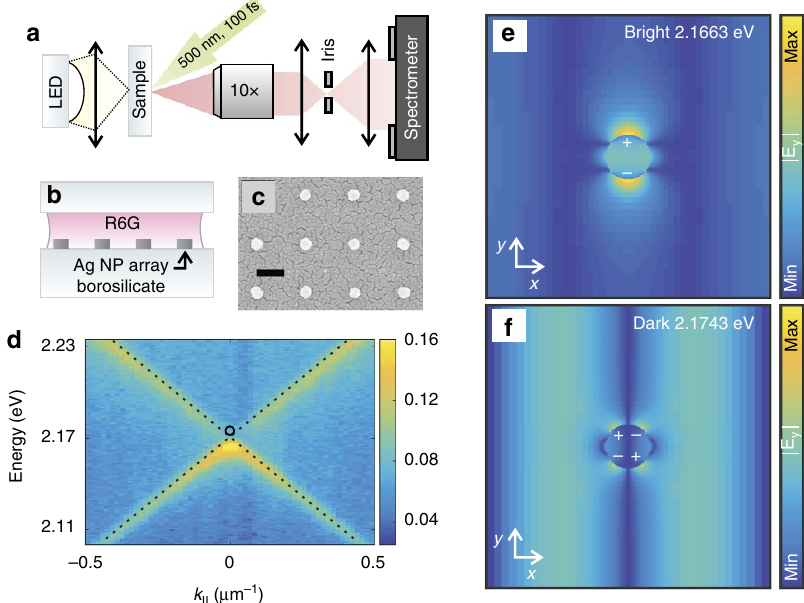
Figure 1 | Measured dispersion of the SLR modes. ( a ) The angle-resolved transmission/luminescence spectra were collected by focusing the image of the backfocal plane of the objective to the entrance slit of the spectrometer. For transmission measurements, a white light source was used. For